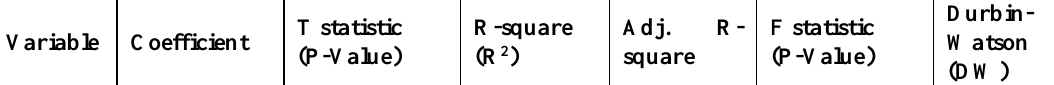
Table 5: Cross-section fixed effect panel multiple regression model to examine the IIC of EVA with SR compared to profitability